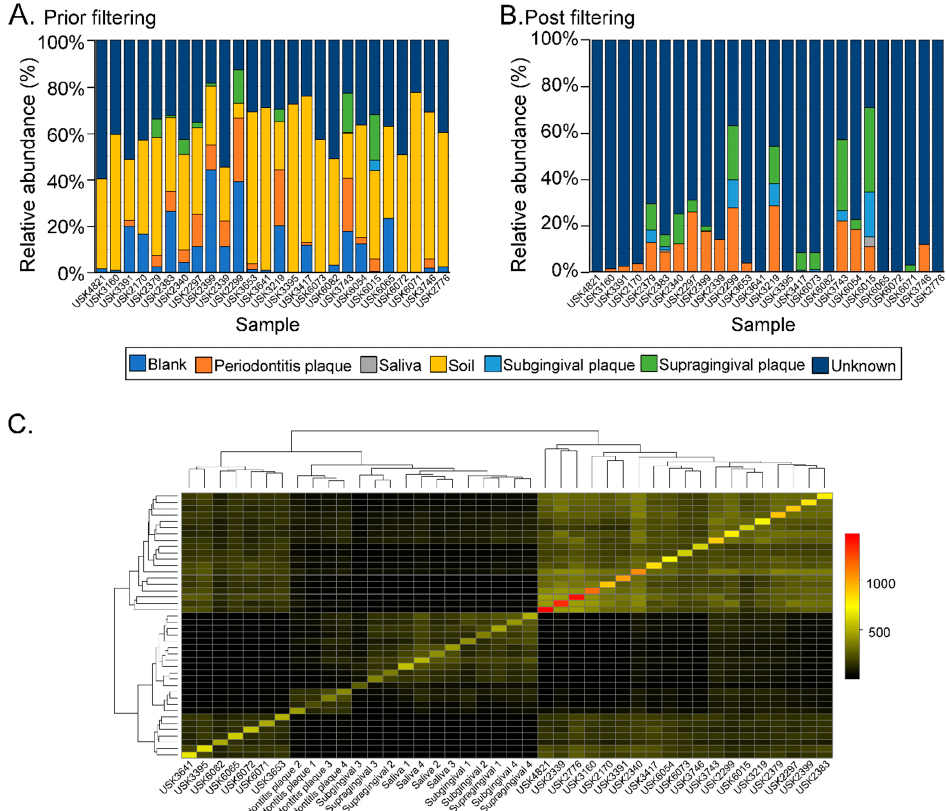
Figure 2. SourceTracker analyses. ( Panel A ) shows the relative abundance of the dental calculus OTUs resembling those of the extraction blank control, and dental plaque of subjects with periodontitis, saliva, soil, subgingival plaque, and supragingival plaque. Dental calculus operational taxonomic units (OTUs) that did not match the included microbiomes were classified as “unknown”. ( Panel B ) shows the relative abundance of OTUs in the dental calculus sample post-filtering OTUs identified in the soil samples from the archeological site, as well as the extraction blank control. ( Panel C ) shows a heatmap of the number of OTUs shared between the dental calculus and modern microbiome samples (i.e., saliva and dental plaque from healthy subjects and those with periodontitis). Genes 2019 , 10 , 299